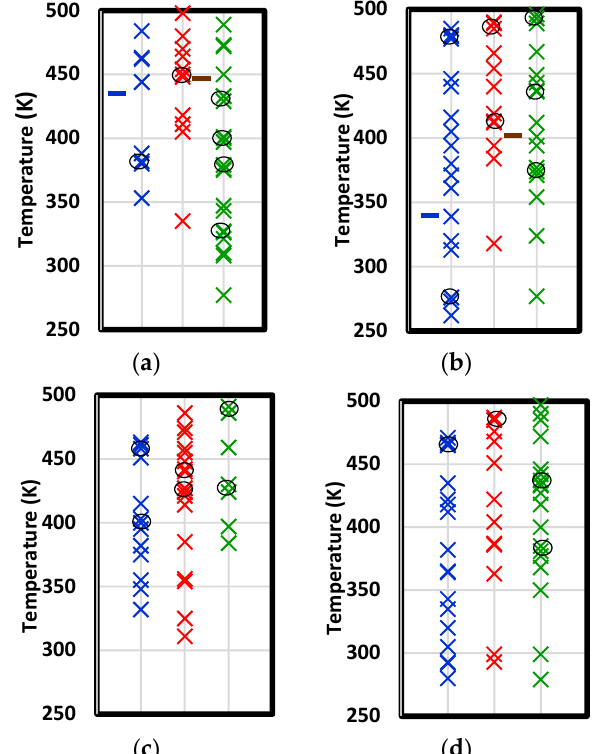
Figure 12. Temperatures of concavity peaks in the specific volume versus temperature plot upon cooling for short-chain stoichiometric ( a ), short-chain excess epoxide ( b ), long-chain stoichiometric ( c ), and long-chain excess epoxide ( d ) formulations. Symbols are colored according to: amine addition only (blue), amine addition and etherification (red), and subsequent dehydration (green). Points were obtained from five thermal cycles. Instances of least three peaks within a range of 10 K are circled. Fiducial marks in ( a ) and ( b ) are the measured T g values of Gupta et al. [6] for cured (blue) and post-cured (brown) specimens.